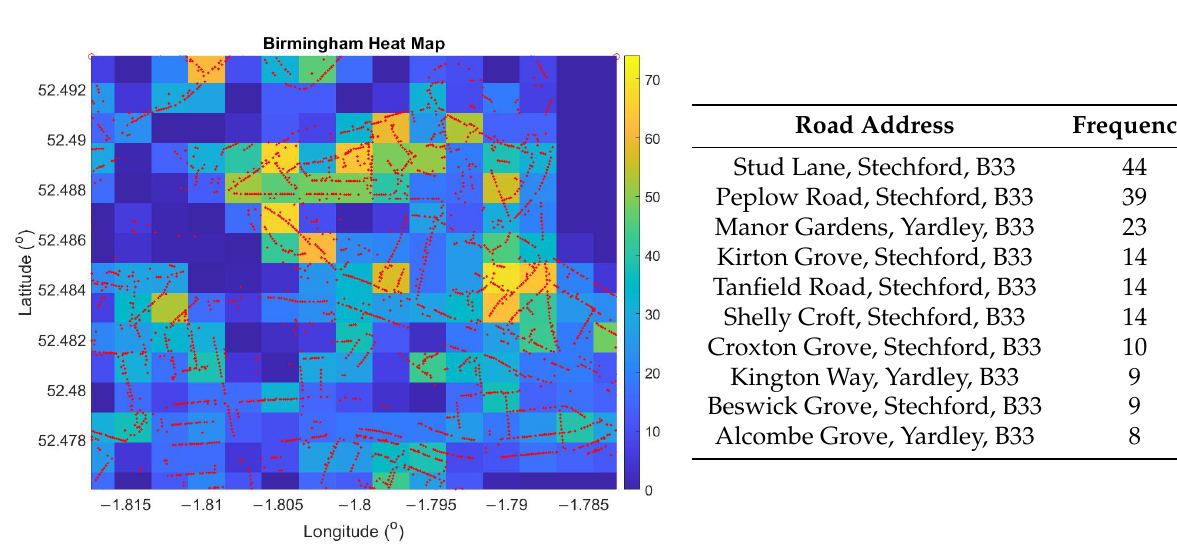
Figure 11. A heat map showing the areas with the highest density of Electric Vehicles (EV) suitable properties in the Birmingham test area as well as the individual locations of EV suitable properties plotted in red ( Left ). A list of the top 10 roads most suitable roads for EV charging ranked by frequency of occurrences ( Right